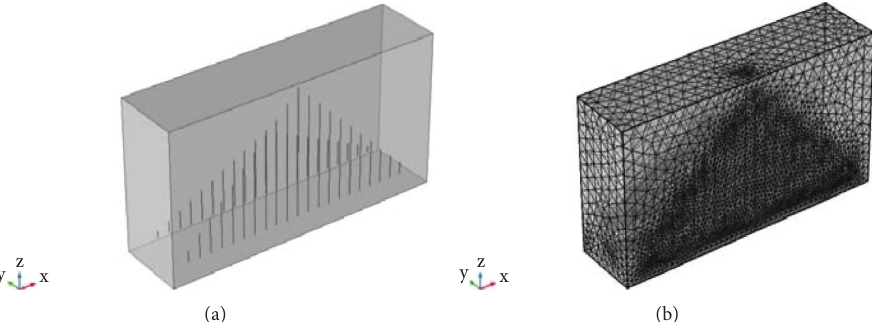
Figure 2: Finite element model. (a) Wind field simulation. (b) Calculation